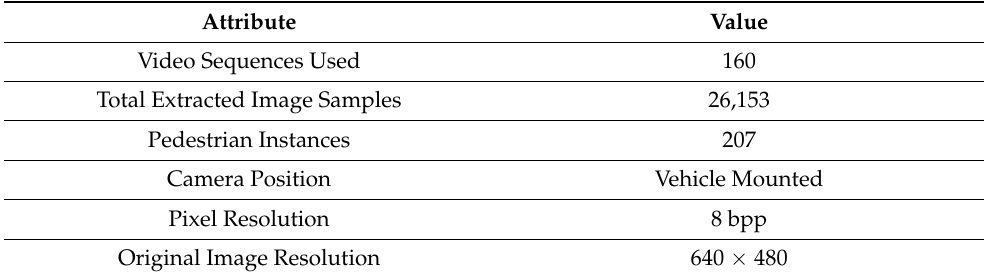
Figure 8. Sample images from the created dataset extracted for the same pedestrian instance. Table 2. Attributes of the constructed